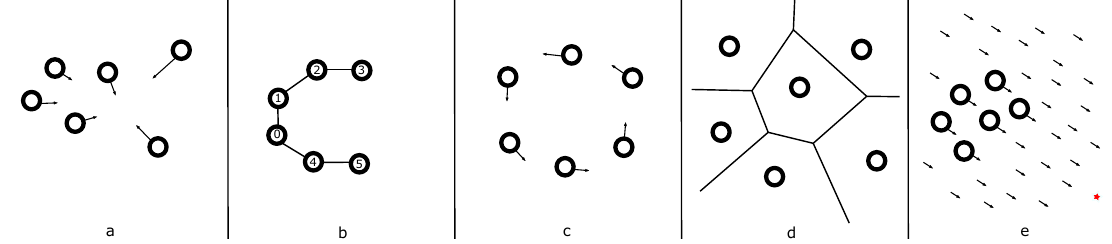
Figure 2: Common swarm behaviors implemented for this study: a- aggregation, b- graph formation, c- cyclic pursuit, d- autonomous de- ployment, e-